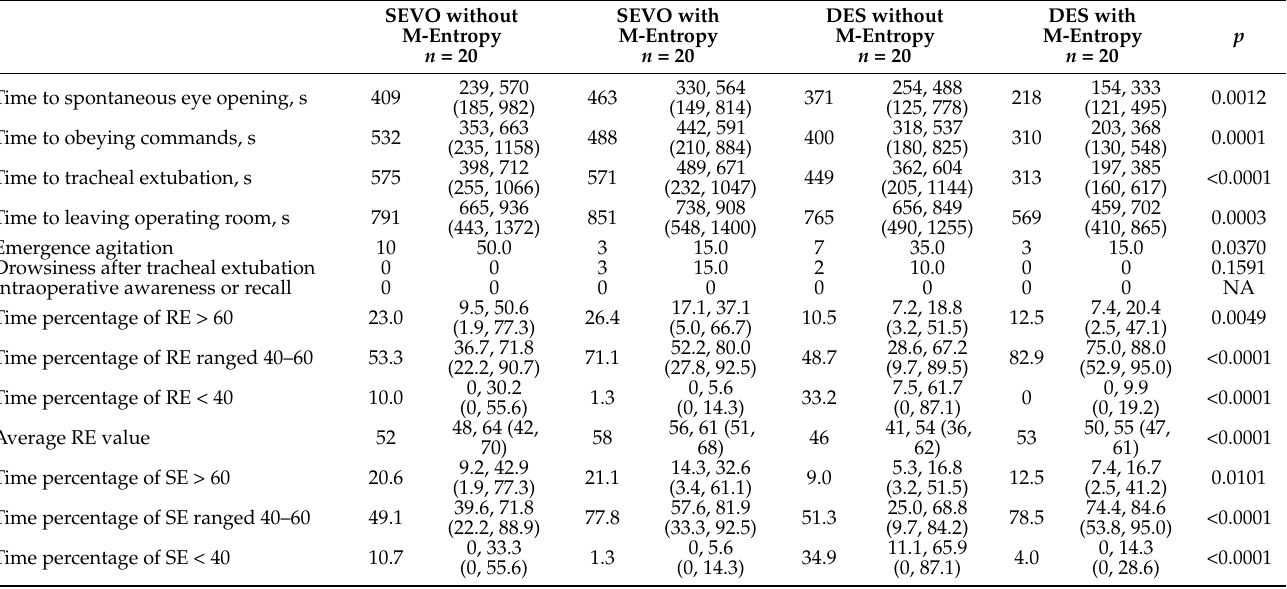
Table 4. Study outcomes of the four groups of sevoflurane or desflurane anesthesia with or without M-Entropy